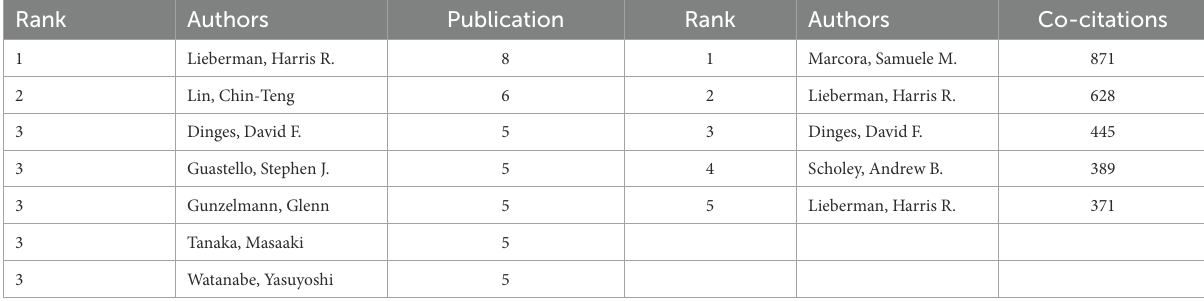
TABLE 5 The top 5 authors in the number of publications and co-cited authors.